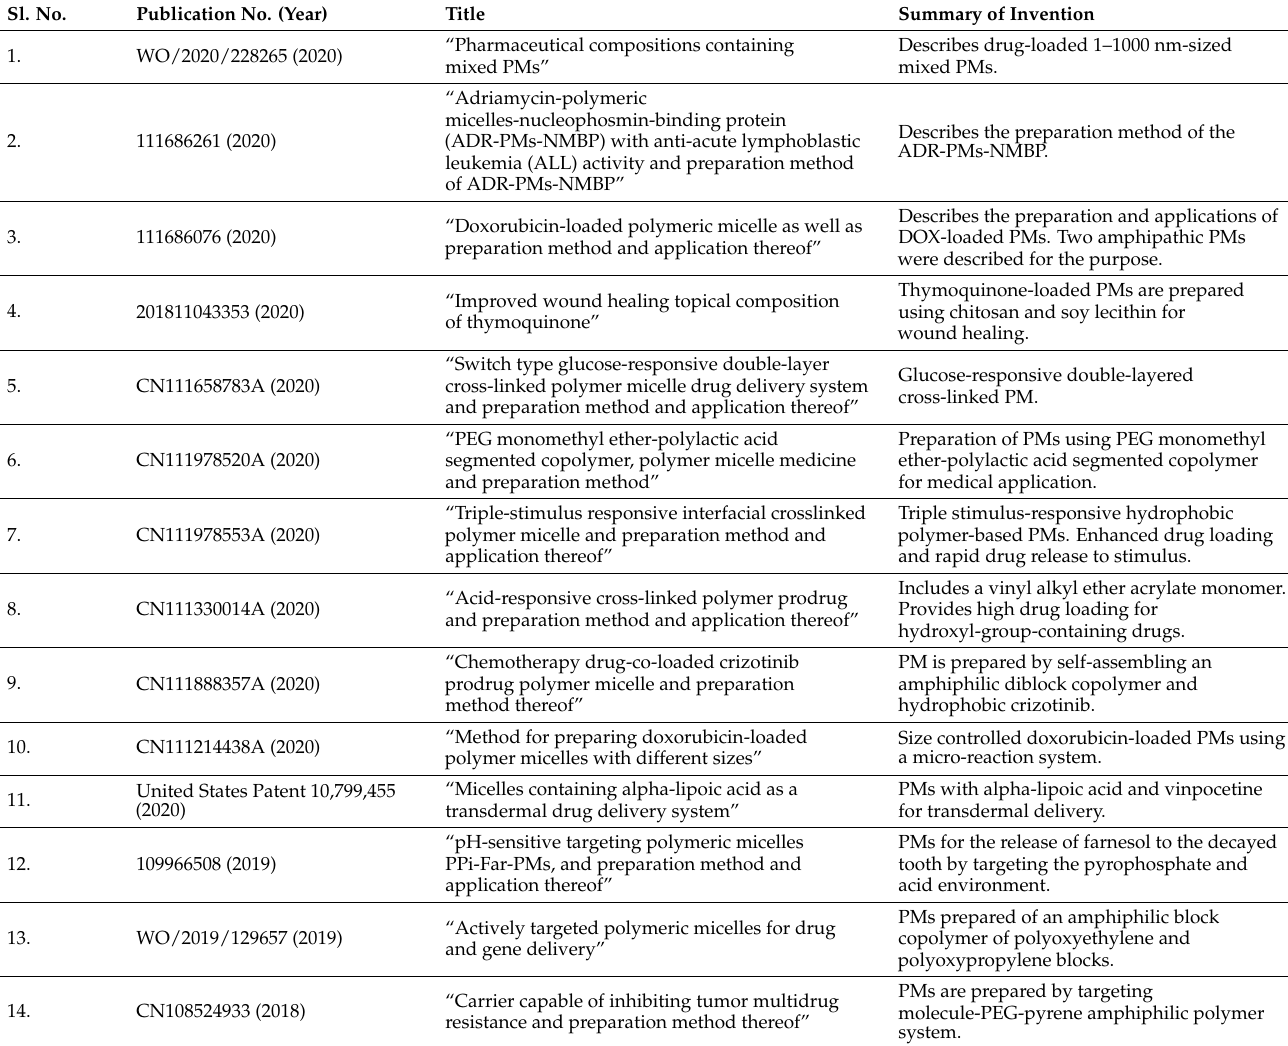
Table 2. Recent patents related to PMs and their drug delivery